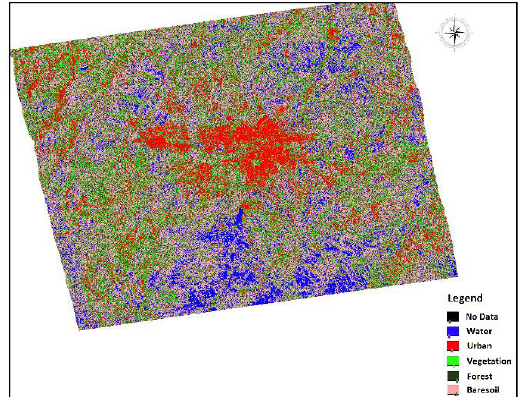
Figure 7. Land cover map derived from Sentinel (generated from